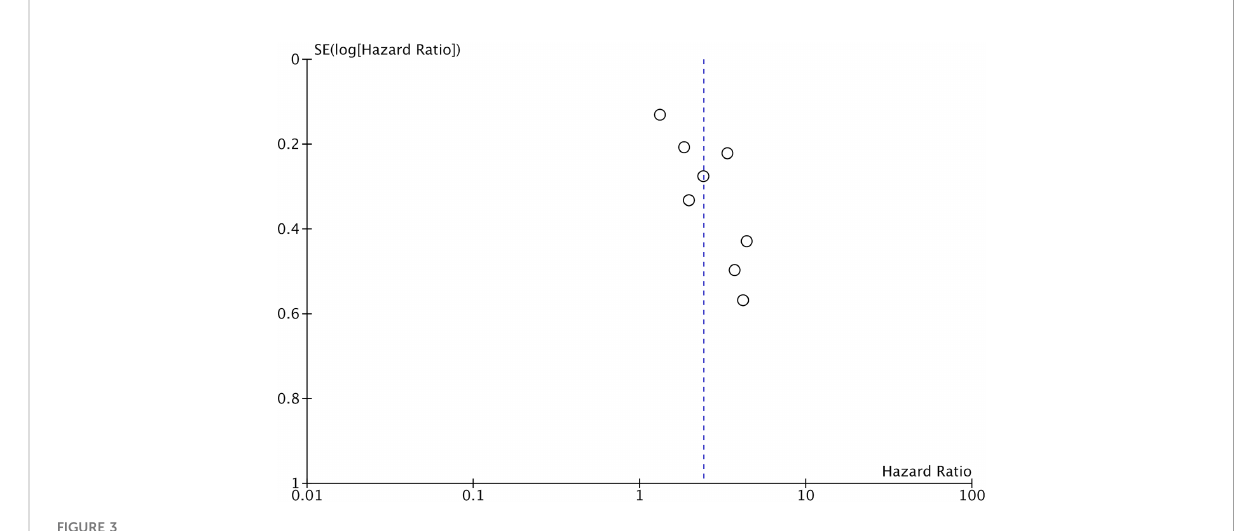
FIGURE 3 Funnel plot for the meta-analysis on the prognostic ability of GNRI for OS in CRC